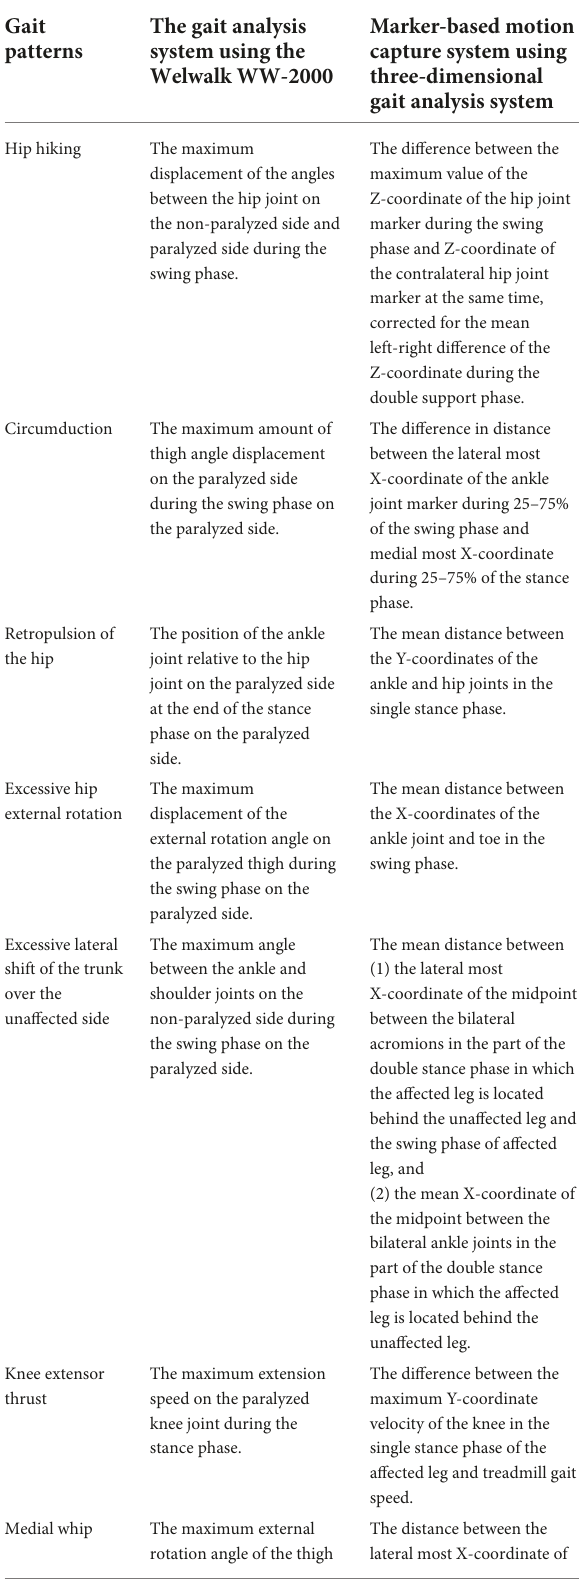
TABLE 1 Definitions of index values of abnormal gait patterns for the gait analysis system in the Welwalk WW-2000 and marker-based motion capture